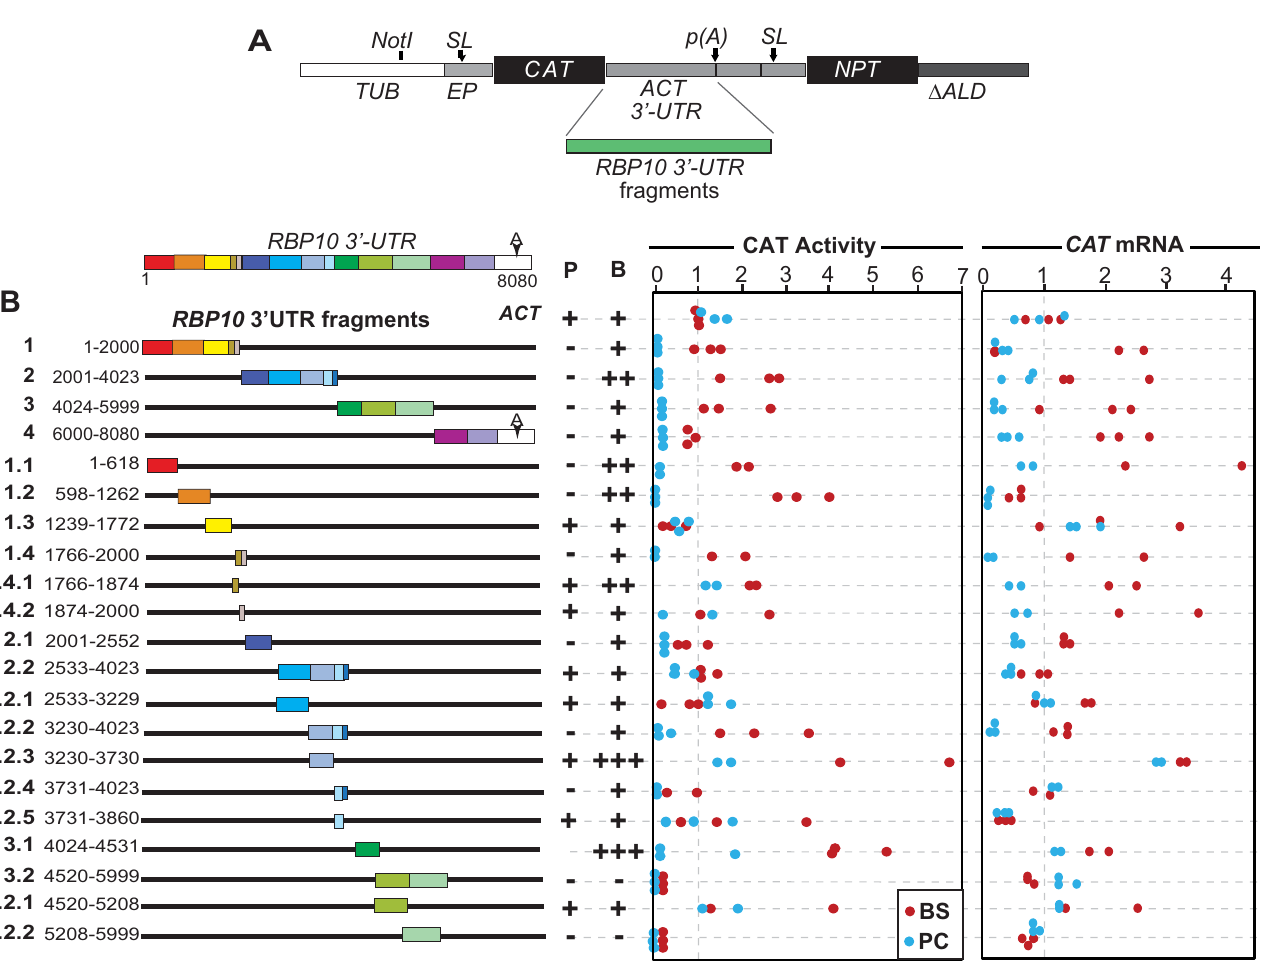
Fig 2. The RBP10 3’-UTR contains several regulatory sequences. A. Cartoon showing the CAT reporter construct (pHD2164) used in this study. The different fragments of the RBP10 3’-UTR were cloned downstream of the CAT reporter coding sequence. The polyadenylation site "p (A)" is specified by the NPT splice signal. SL indicates the spliced leader addition sites. ACT denotes actin. B. Schematic diagram of the RBP10 3’-UTR segments used to map the regulatory sequences. Different segments are in different colours and the diagram is to scale. Measurements of CAT activity and mRNA levels are on the right. Each dot is a result for an independent clone, with blue and red representing bloodstream (B) an procyclic (P) forms, respectively. Values were normalized to those for